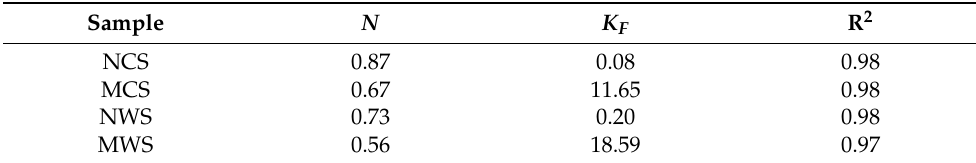
Table 6. The Freundlich isotherm constants for removal of Pb(II).